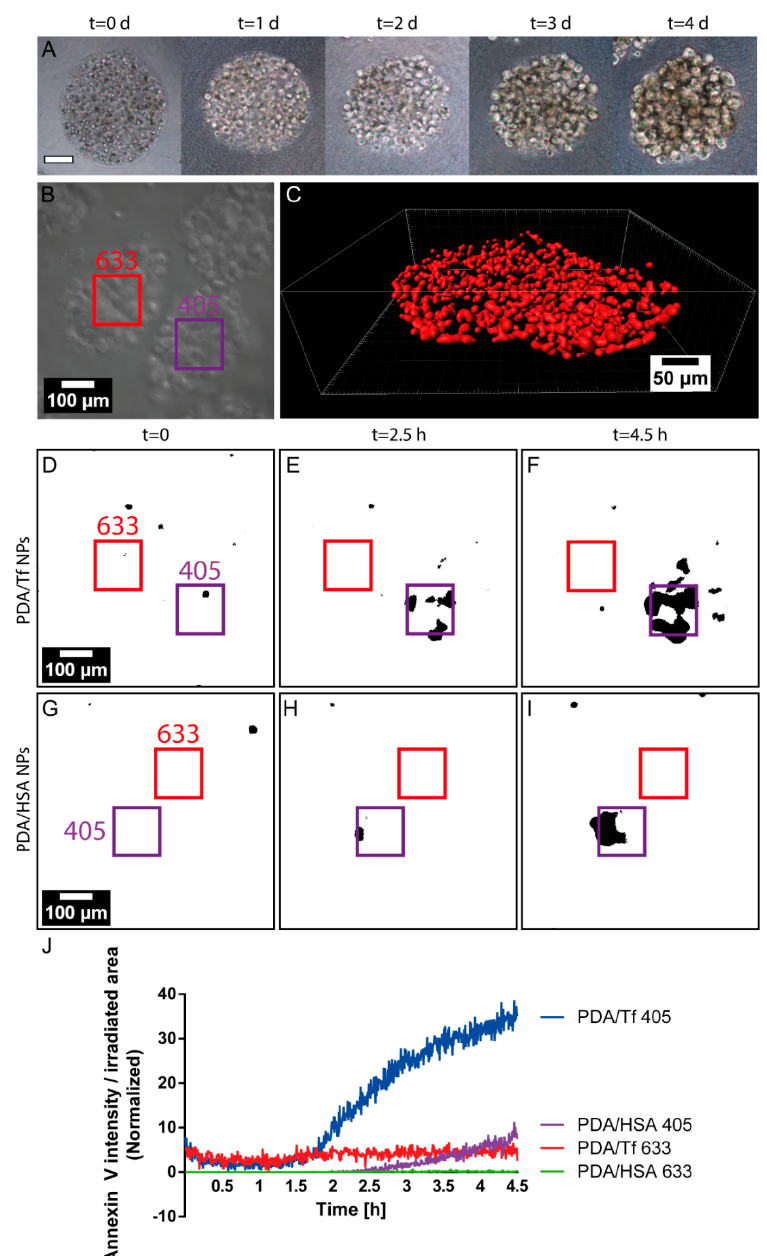
Figure 8. Light-induced apoptosis using melanoma spheroid models. The development of the spheroid model is depicted in the representative images in panel ( A ), corresponding to the increasing time-points during their growth. Representative phase contrast image of the spheroid model with the selected regions of elevated irradiation with 405 nm (violet) and 633 nm (red) laser light ( B ). Rendered cLSM z-stack of the stained B16F10 assembled into the spheroid model, after 24 h of development ( C ). Analyzed frames of the videos showing the B16F10 spheroids, exposed to the PDA/Tf NPs, at time point 0 ( D ), after 2.5 h ( E ), and 4.5 h ( F ), and spheroids exposed to the PDA/HSA NPs, at time point 0 ( G ), after 2.5 h ( H ), and 4.5 h ( I ). Every frame of the videos was analyzed and the Annexin V intensity per irradiated area, either 405 (violet) or 633 (red), was recorded and is shown in panel ( J ). The blue line represents the cell-death rate of the samples treated with the PDA/Tf NPs, the violet line is that of the samples treated with the PDA/HSA NPs, and both were irradiated with a 405 nm laser light. The red line represents the cell-death rate of the samples treated with the PDA/Tf NPs, the green line shows the samples treated with the PDA/HSA NPs (both irradiated with 633 nm laser light). N of PDA/Tf = 2 and N of PDA/HSA =